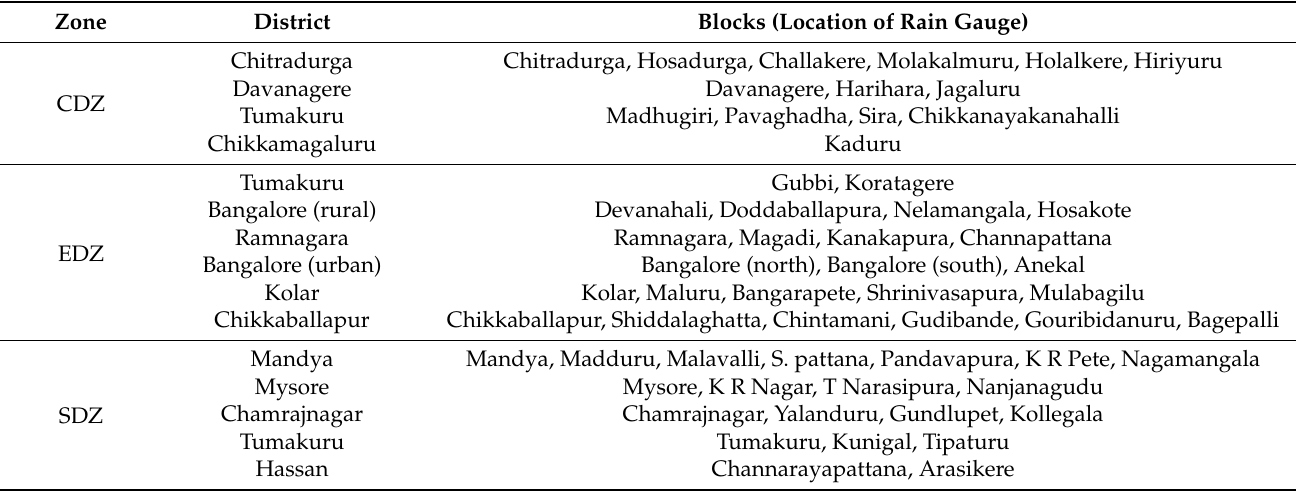
Table 1. Districts and blocks of SIK from where rainfall data was